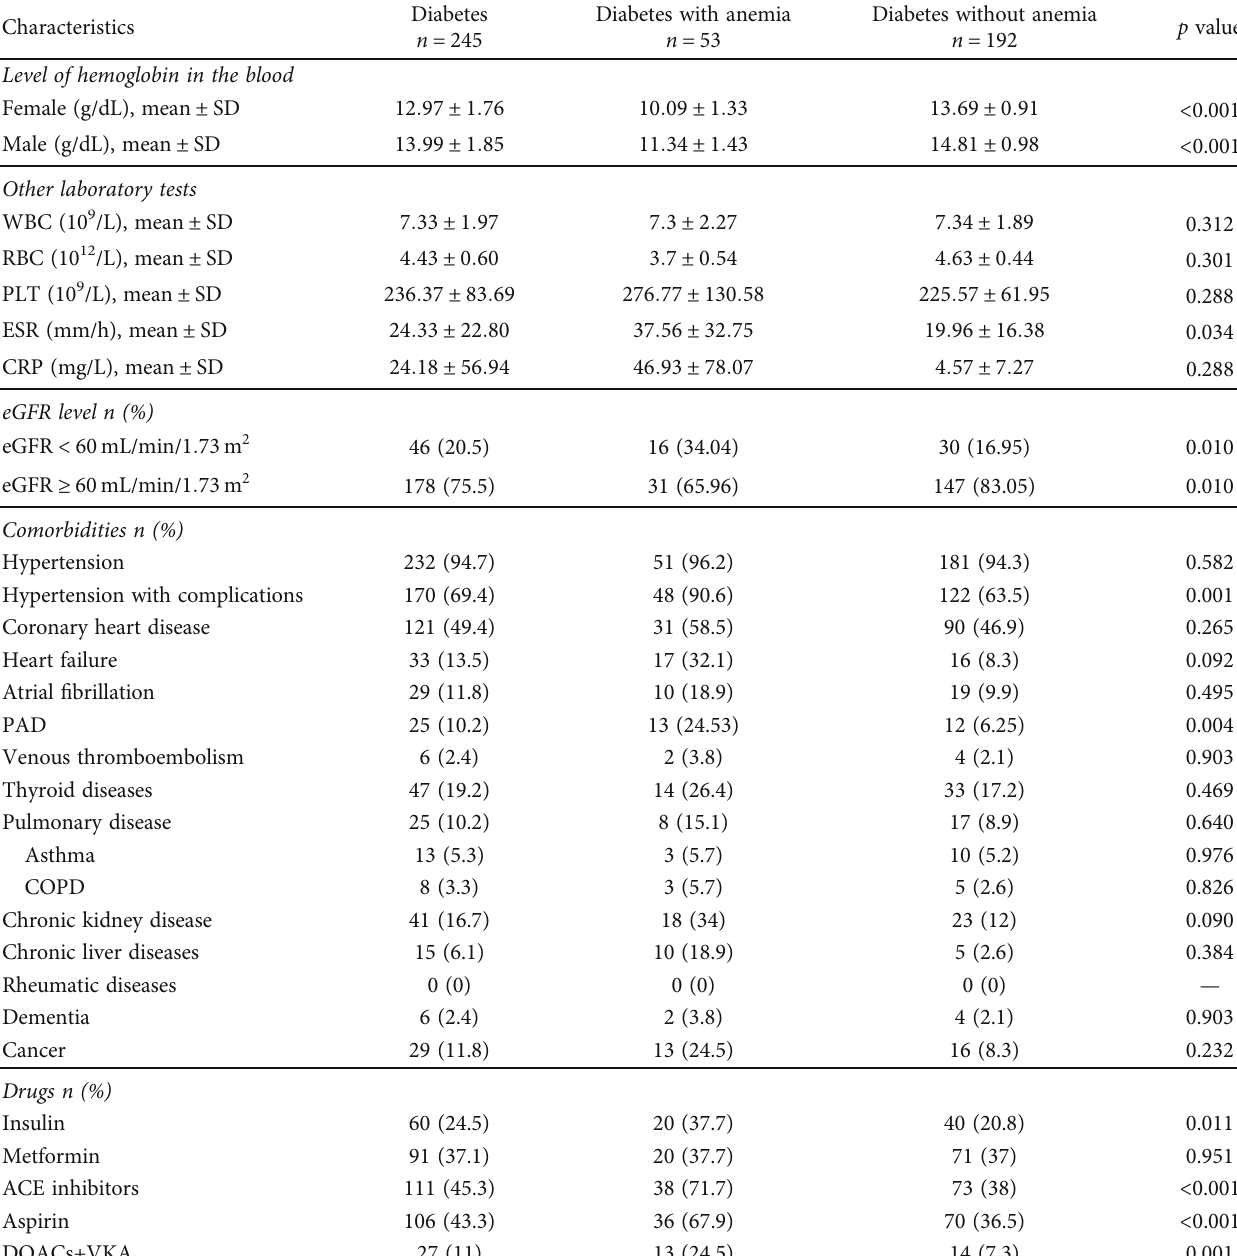
Table 3: Clinical characteristics of diabetic patients with and without